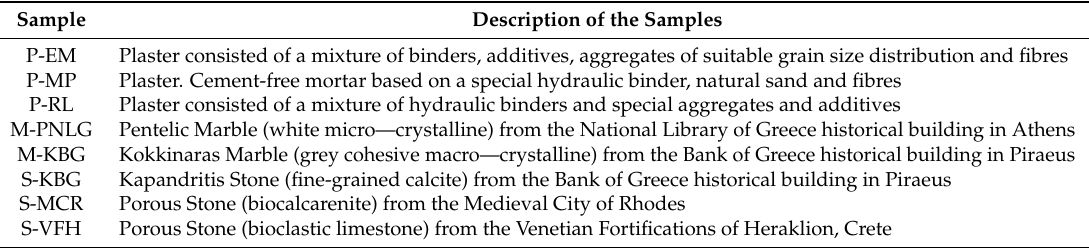
Table 1. Description of samples examined in the laboratory.